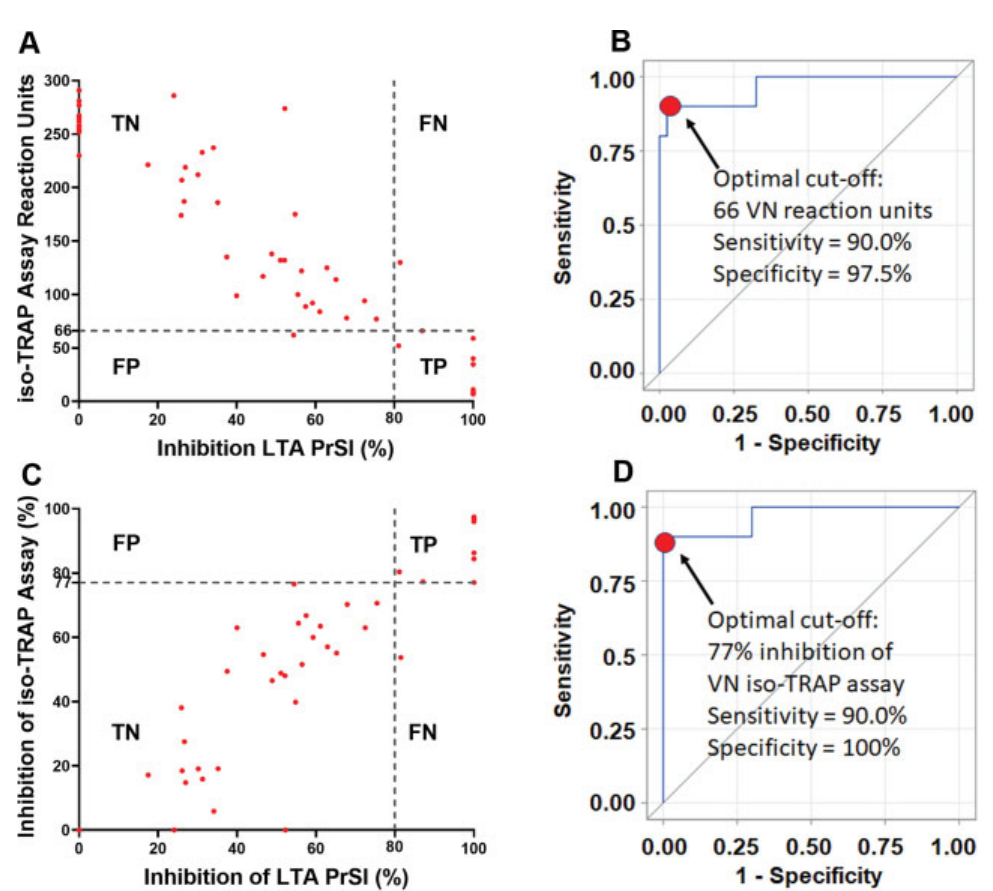
Fig. 4 ROC curves identifying the VN PRUTest iso-TRAP assay reaction units that correspond to 80% or greater inhibition of the PrSl of ADP (20 µM)-induced LTA in patients on aspirin treated with RUC-4. ( A ) Reaction unit scatter plot. ( B ) Reaction unit ROC curve, identifying the optimal cut- off value as 66 reaction units. ( C ) Percentage inhibition scatter plot. ( D ) Percentage inhibition ROC curve, identifying the optimal cut-off as 77%. LTA was performed with PRP prepared from PPACK-anticoagulated blood, VN testing was performed with citrate-anticoagulated blood. n ¼ 11 donors, 50 measurements. ROC ¼ Receiver operating characteristic; VN ¼ VerifyNow; PrSl ¼ Primary Slope; LTA ¼ Light transmission aggreg- ometry; PRP ¼ Platelet-rich